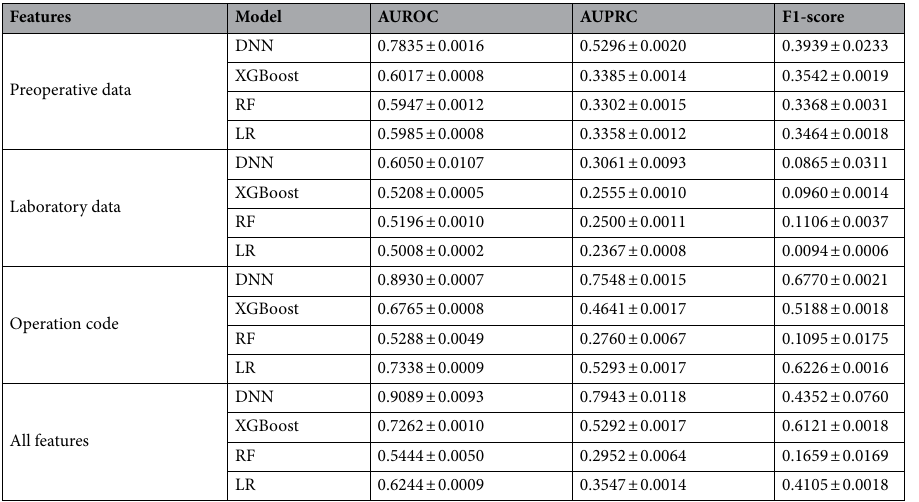
Table 2. Predictive performance of arterial catheterization according to each modeling method using the deep or machine learning technique and a combination of features. Data represent means (95% confidence intervals). AUROC, area under receiver operating characteristic; AUPRC, area under precision-recall curve; DNN, deep neural network; XGBoost, extreme gradient boosting; DT, decision tree; RF, random forest; LR, logistic regression; ASA-PS, American Society of Anesthesiologists physical